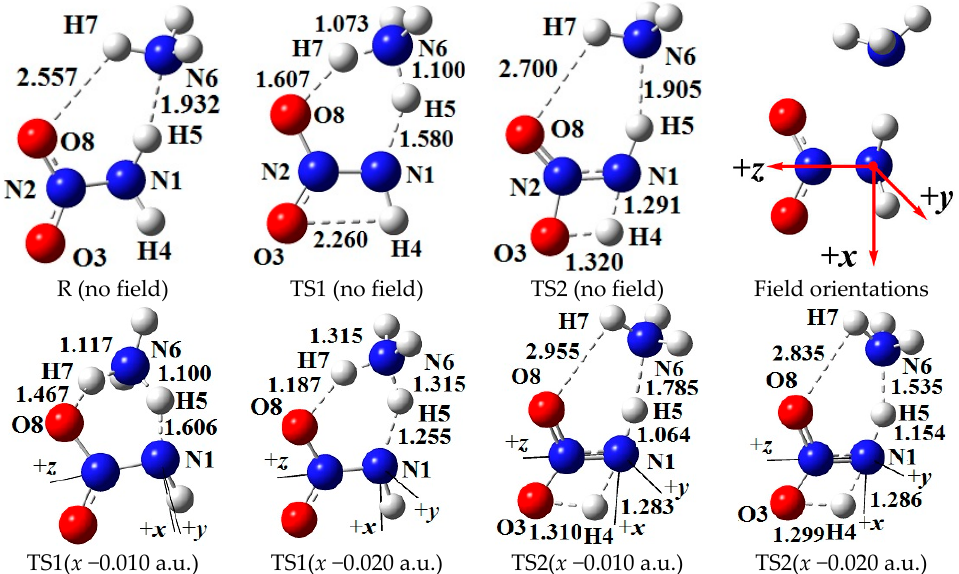
Figure 1. Selected structures of the reactant (R), transition states (TS) in the different external electric field strengths and orientations (including those in the absence of field) at the MP2/6-311++G(2d,p) level (geometric parameters are in Å). The “reaction axes” are N6 → H7 → O8, N1 → H5 → N6, and N1 → H4 → O3.